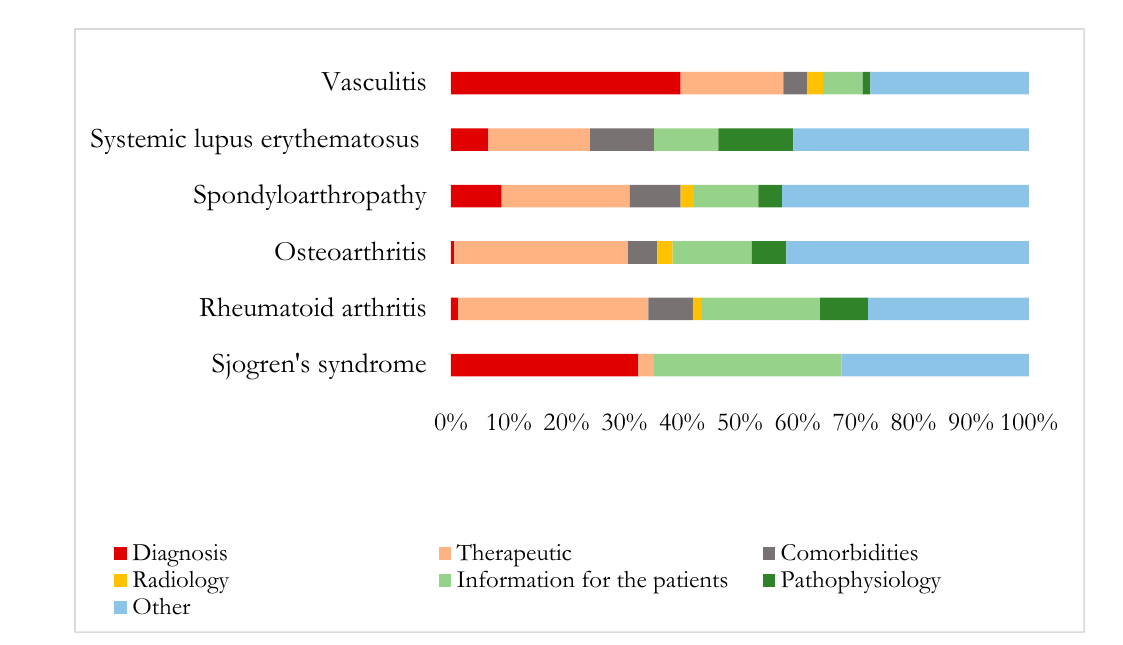
Figure 2. Proportion of the different medical contents among the tweets related to each rheumatic disease. Test χ 2 p < 0.001. Spondyloarthropathy includes: spondyloarthritis, ankylosing spondylitis, psoriatic arthritis, reactive arthritis, and spondylitis. The p -value of the Chi-square test for the differences between the percentages of the different medical contents of the tweets related to the rheumatic diseases. Table 3. Number of total tweets with non-medical content, tweets for patient support and tweets about general news by rheumatic